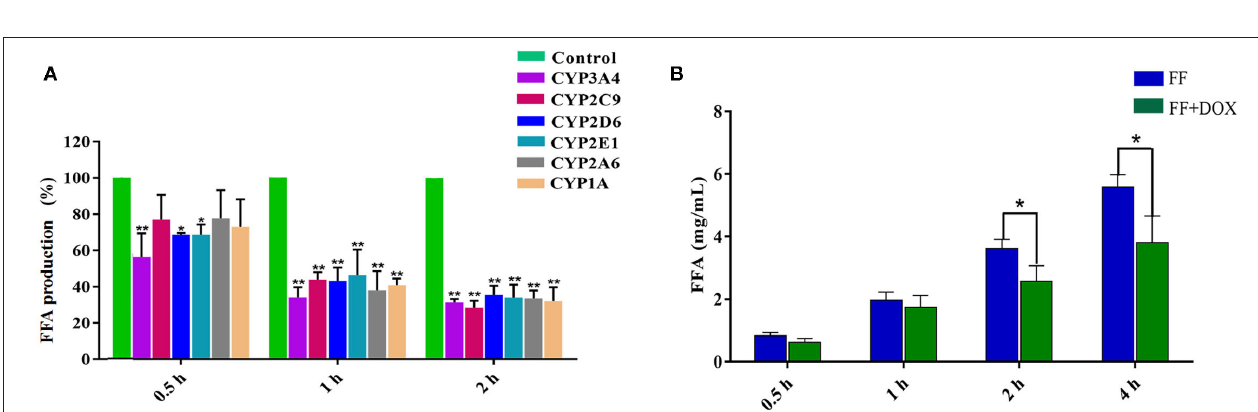
FIGURE 1 | LC-MS/MS method for detecting FF, and FFA. The peak times of FFA and FF were 1.80 and 6.05min, respectively.